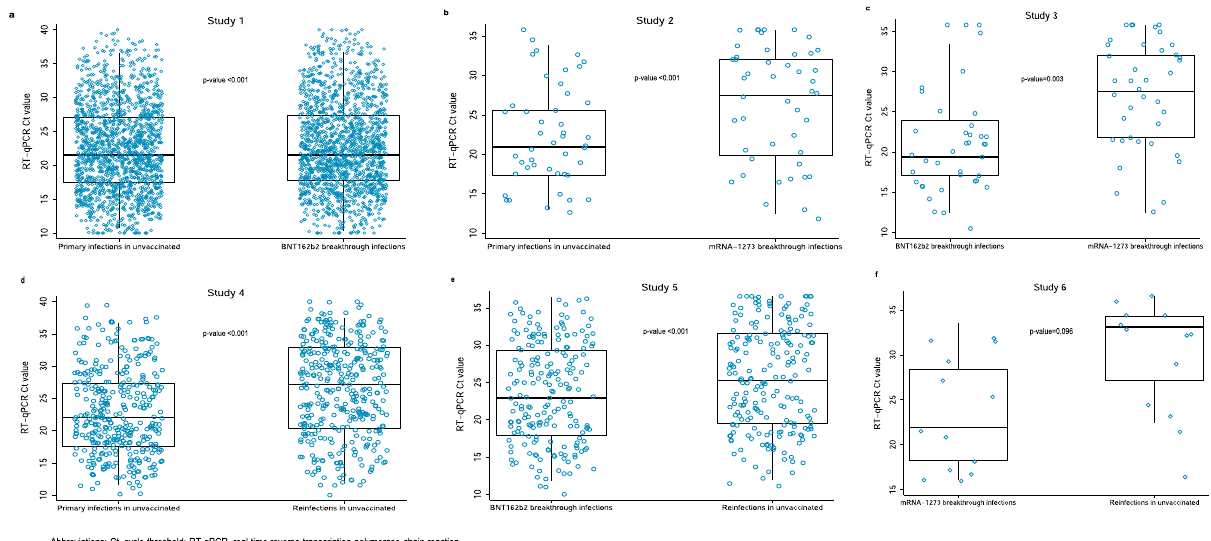
Fig. 3 RT-qPCR Ct values in the randomly diagnosed (asymptomatic) SARS-CoV-2 infections. Distribution of these Ct values (blue circles) in the six pairwise comparisons between primary infections in unvaccinated individuals, reinfections in unvaccinated individuals, BNT162b2-vaccine breakthrough infections, and mRNA-1273-vaccine breakthrough infections, a – f . A randomly diagnosed infection was de fi ned as an RT-qPCR-positive test conducted with no prior reason to suspect infection and no reported presence of symptoms compatible with a respiratory tract infection. That is, the RT-qPCR test was conducted as part of a survey (random testing campaigns), for routine healthcare testing, for pre-travel requirement, or at port of entry upon arrival in Qatar. a includes, in each comparison group, n = 1584 biologically independent samples, b includes n = 158 biologically independent samples, c includes n = 140 biologically independent samples, d includes n = 987 biologically independent samples, e includes n = 421 biologically independent samples, and f includes n = 60 biologically independent samples, each over 1 experiment. Boxplots center lines indicate the median Ct values, box limits indicate the 25% and 75% quartiles, and whiskers indicate maximum and minimum observations within 1.5 of interquartile range. Paired t tests were used to compare the difference in means between study groups, with no adjustment for multiple comparisons. Two-sided p -values are